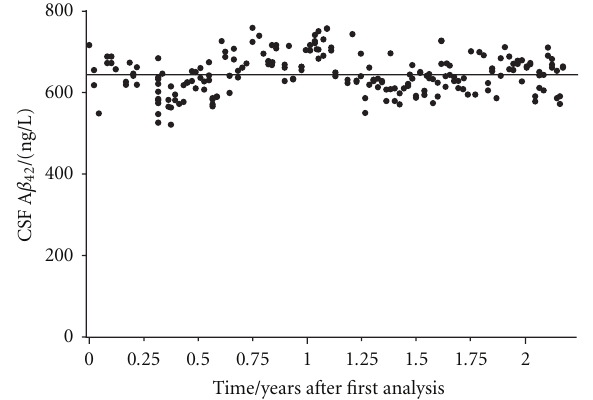
Figure 1: The mean A β 42 variation in CSF during 26 months. An internal quality control sample was run on 214 di ff erent occasions rendering a mean ± SD value (—) of 643 ± 48 ng/L and a CV of